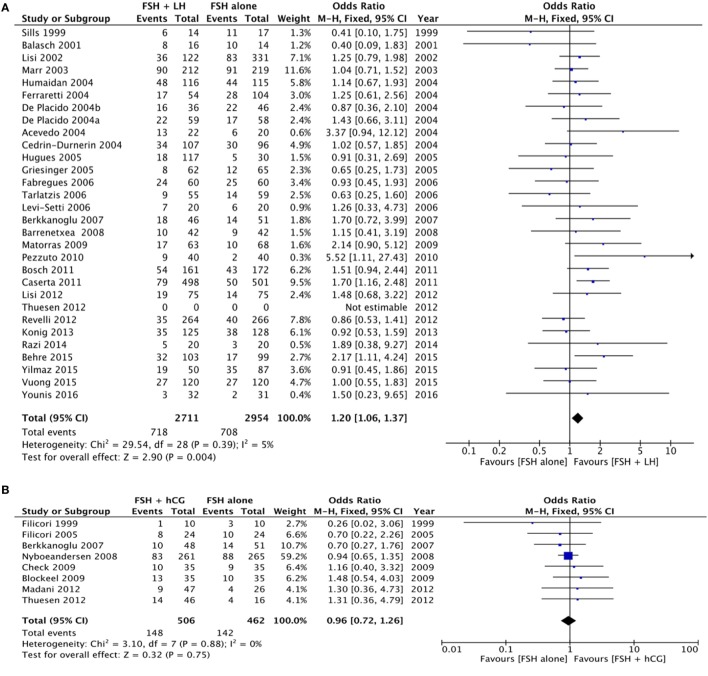
Forrest plot evaluating the pregnancy rate comparing follicle-stimulating hormone alone to luteinizing hormone (A), human chorionic gonadotropin (B), and human menopausal gonadotropin (C).